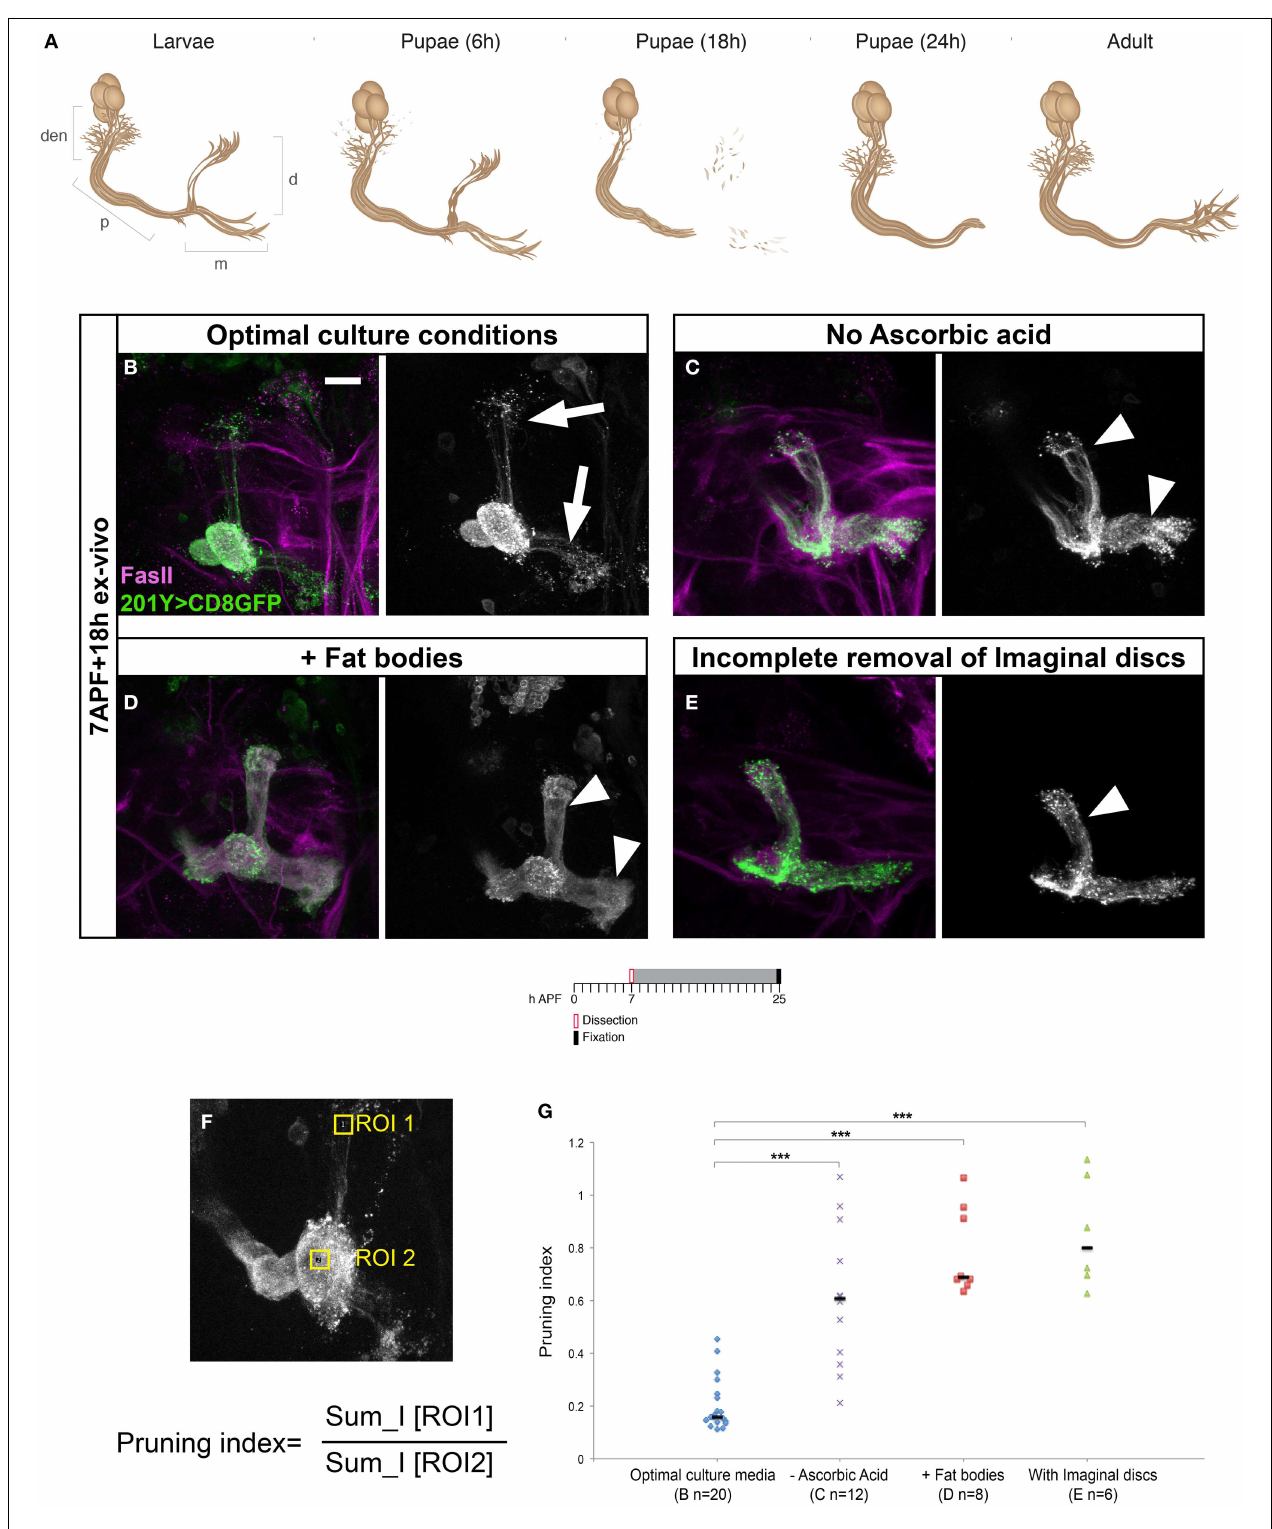
FIGURE 2 | Specific culturing conditions are critical for maximizing ex vivo development of dissected brains. (A) Schematic representation of MB γ neuron remodeling. Den, dendrites; p, peduncular axon; m, medial; d, dorsal, h, after puparium formation (APF). (B–D) Confocal Z-projections of